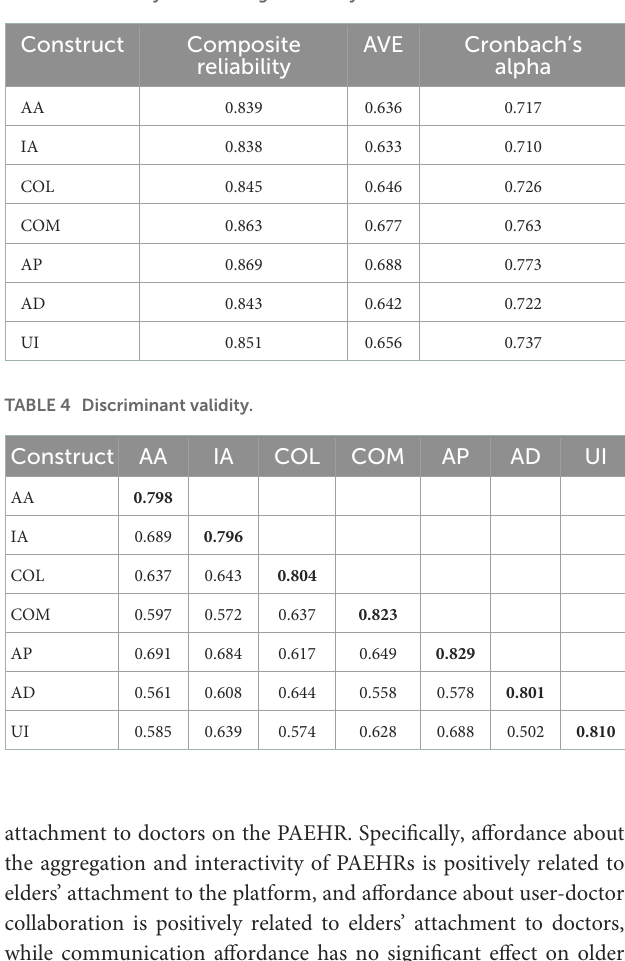
TABLE 5 Loadings and cross